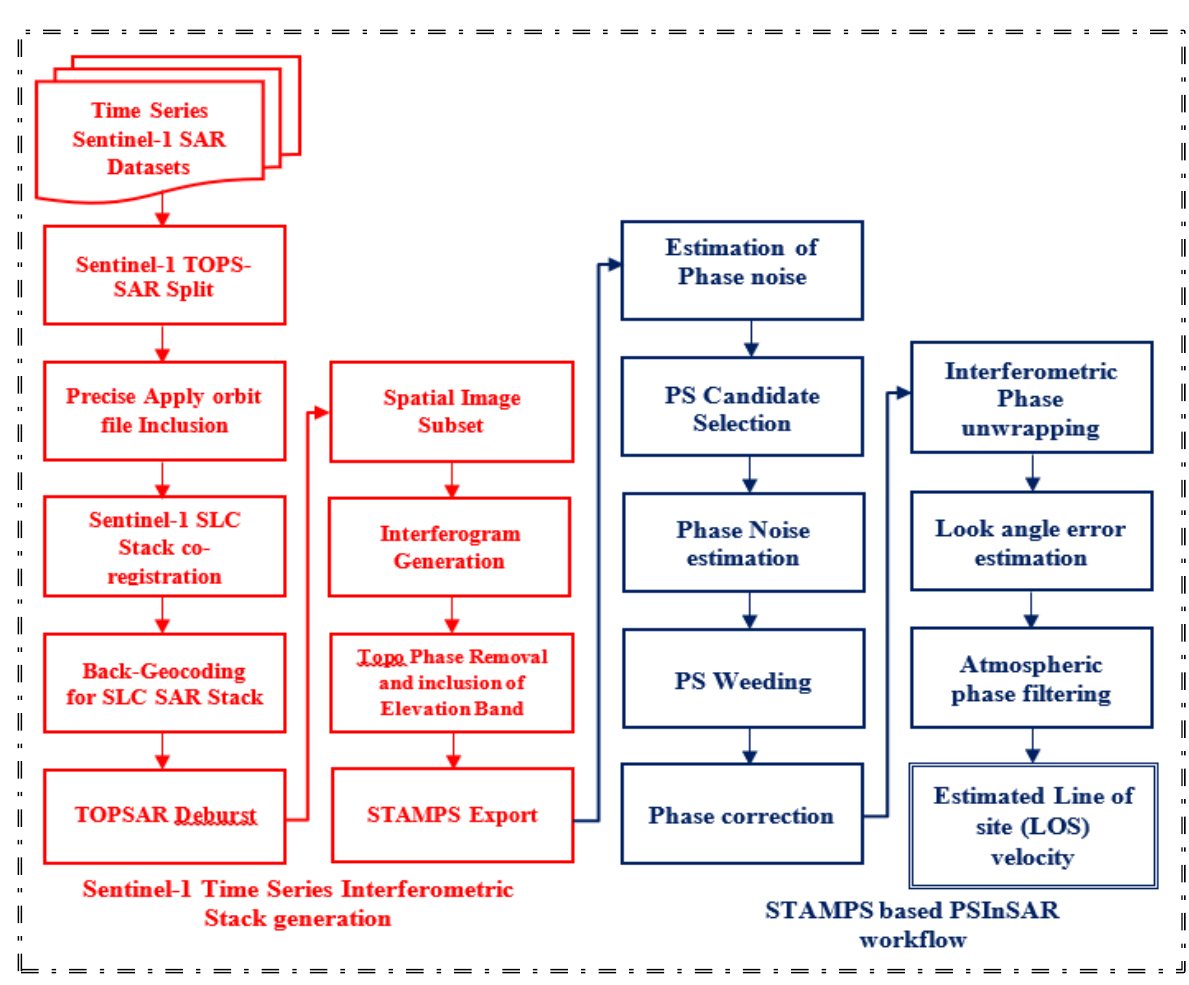
Figure 5. The overall workflow of the Sentinel-1 PSInSAR processing for the retrieval of LOS displacement velocity.